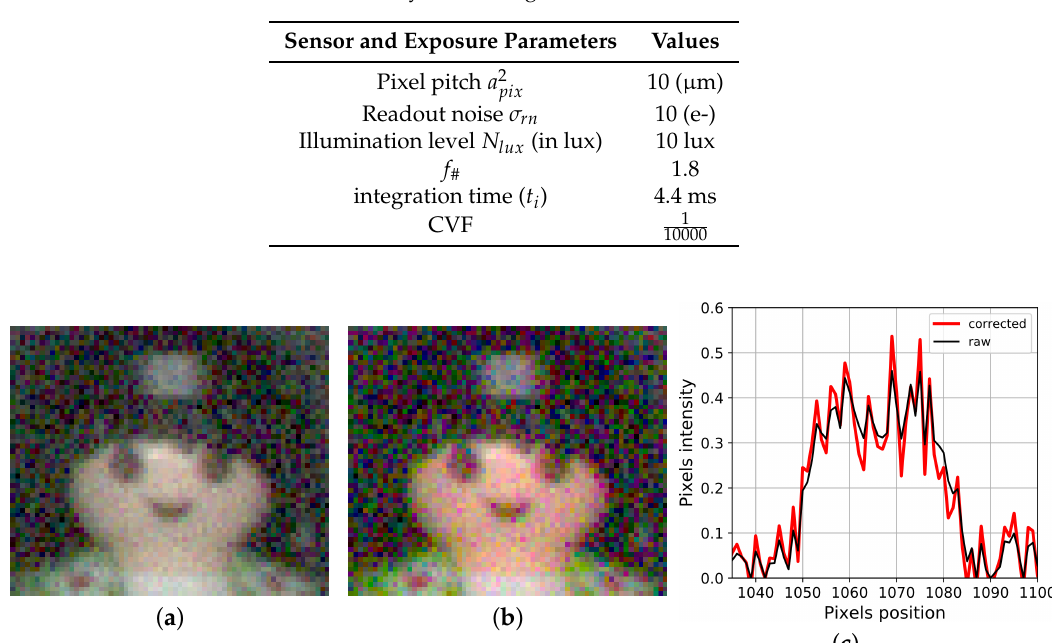
Table 1. Physical setting of the simulation.